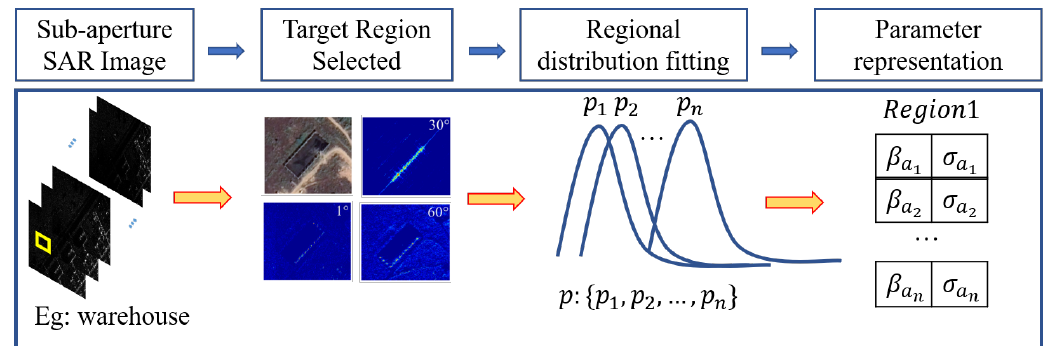
Figure 2. Schematic diagram of parameter